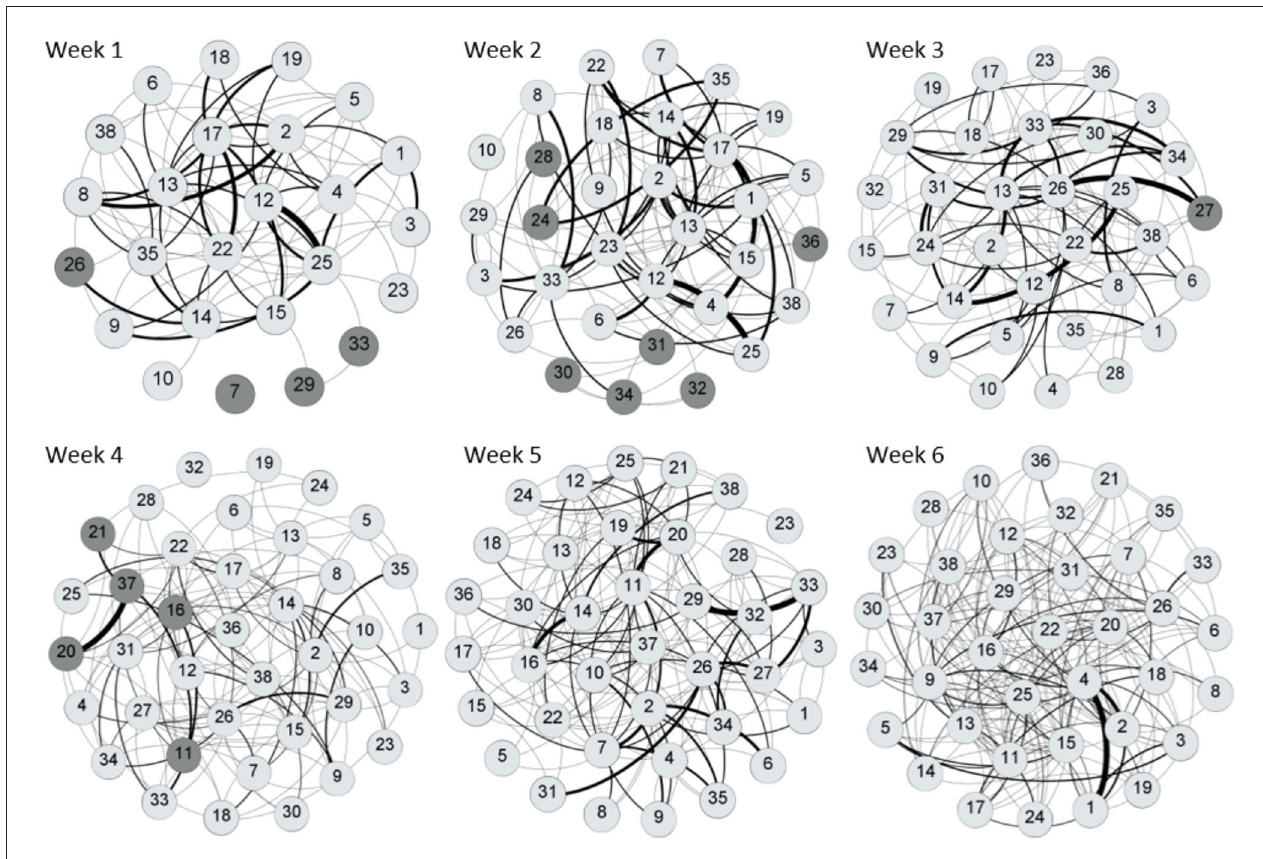
FIGURE 2 | Visualization of the weekly social grooming networks using a Fruchterman Reingold layout. Nodes that are closer together exchanged more ties. Dark gray circles represent cows that were reincorporated to the group each week. Clear gray circles represent cows that were present in the group at least the week before. Tie width is related to the number of interactions, with wider ties indicating higher number of allogrooming bouts. The curve of the tie is turned clockwise, showing the direction of the interaction. Networks were obtained with Gephi 0.9.2 software